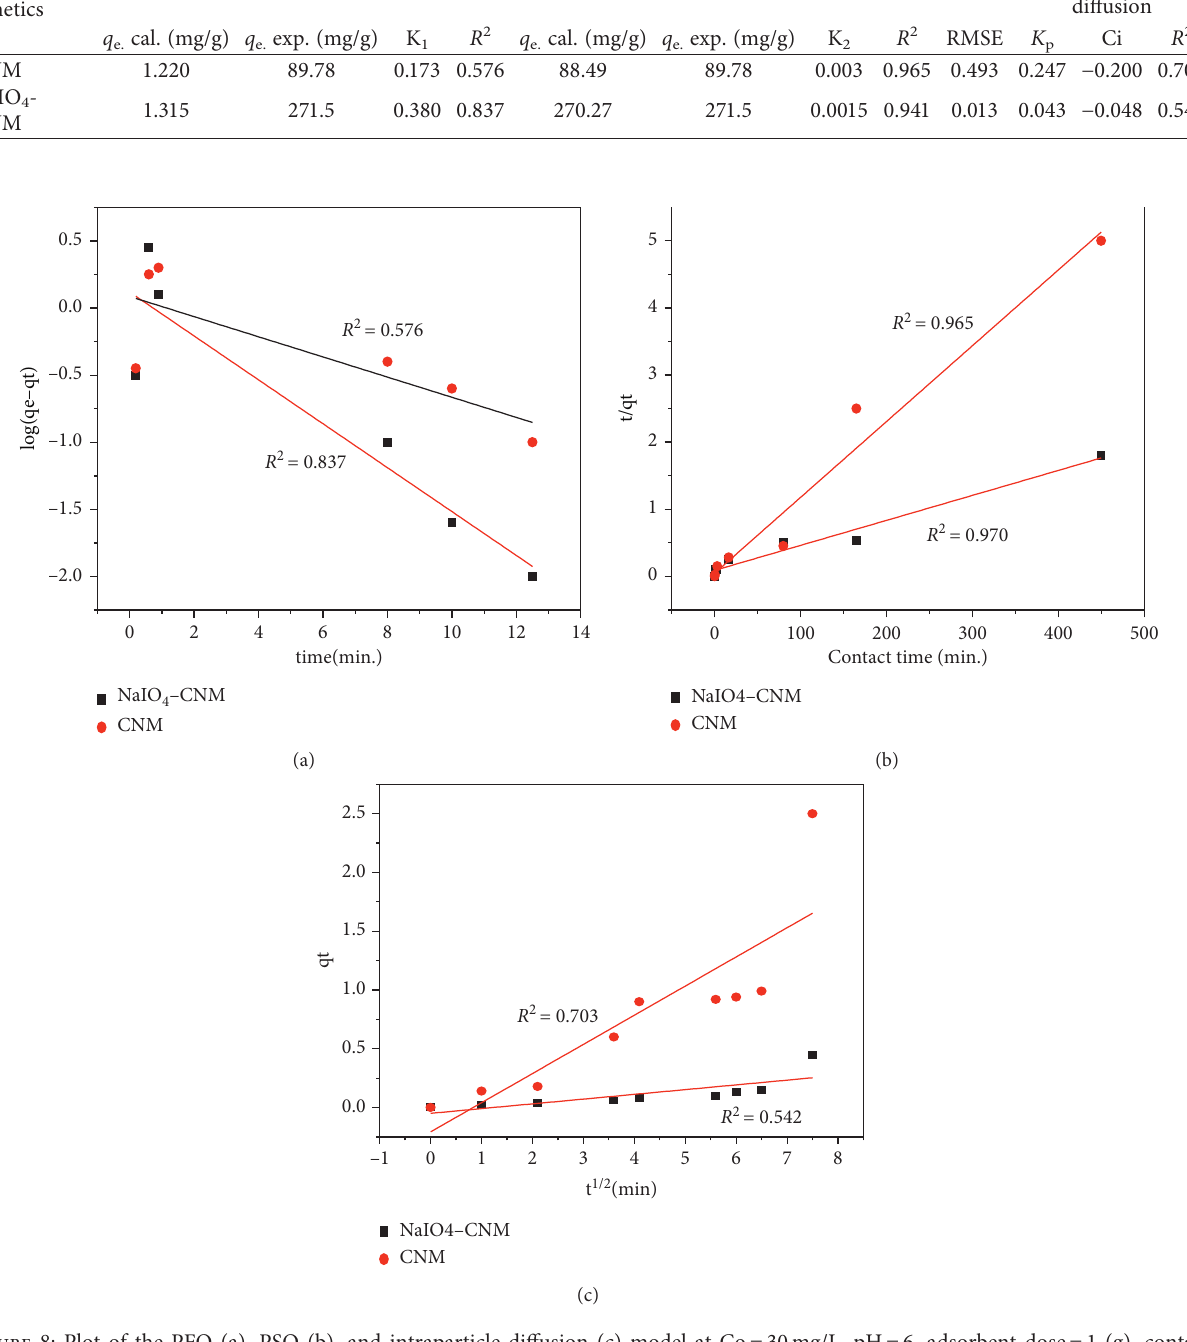
Table 4: The values of parameters and correlation coefficients of pseudo-first-order (PFO), pseudo-second-order (PSO), and intraparticle diffusion kinetic models. PFO PSO Kinetics